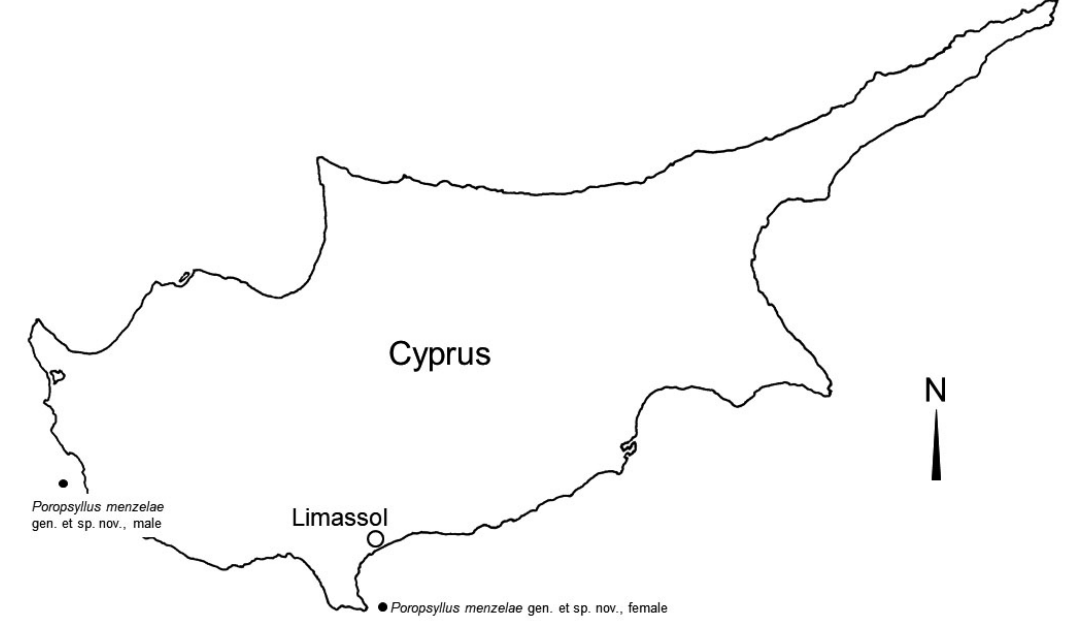
Fig. 1. Map of the island of Cyprus (eastern Mediterranean Sea) showing the locations where the two individuals of Poropsyllus menzelae gen. et sp. nov. were